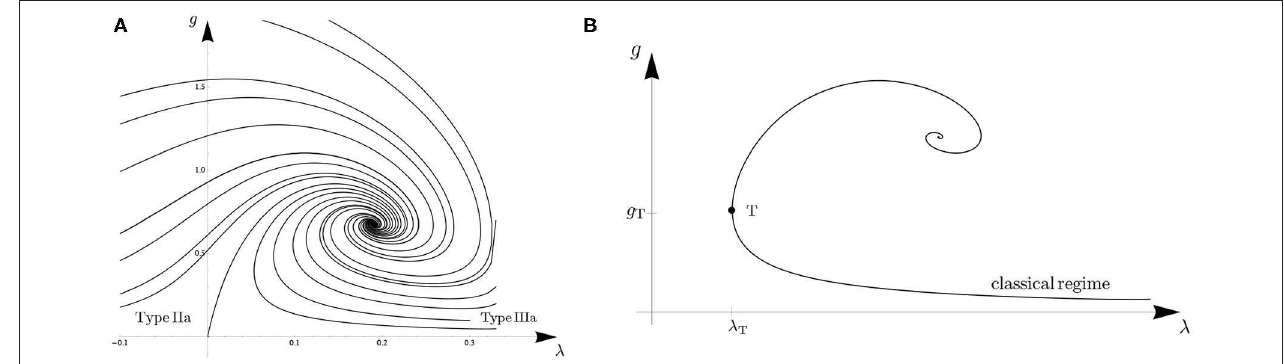
FIGURE 3 | (A) Phase portrait of the RG flow in the Einstein-Hilbert truncation on the dimensionless ( g , λ) -plane. The RG trajectories start out from the UV non-Gaussian fixed point and flow toward the IR. (B) An example of a trajectory of Type IIIa. Its turning point (λ T , g T ) is passed when k